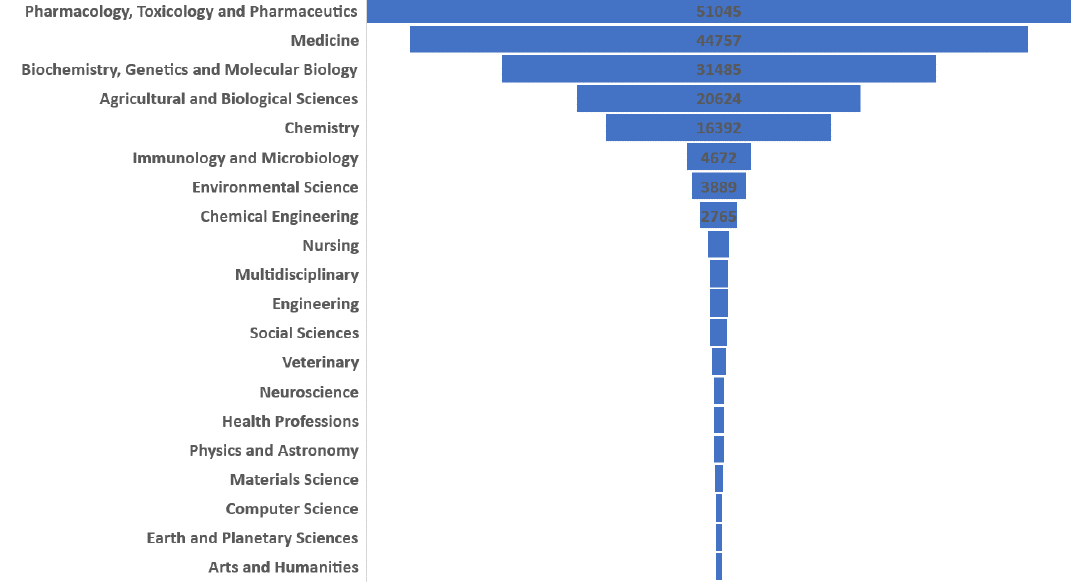
Figure 3. Medicinal plants publications by scientific categories indexed in Scopus.